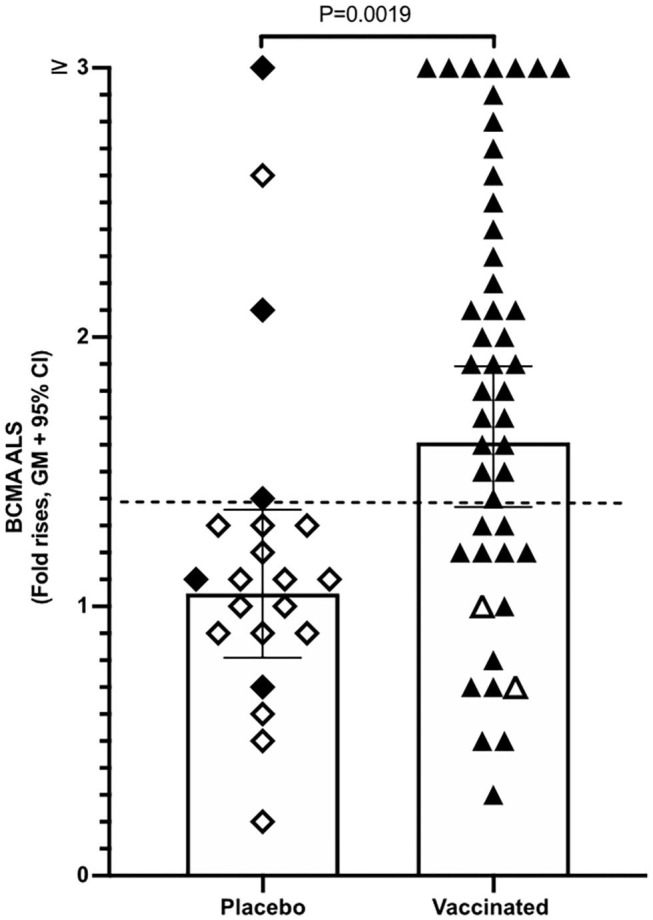
ALS BCMA responses is higher in orally vaccinated subjects than in placebo recipients. Magnitudes of ALS BCMA responses from volunteers were primed with 2 oral doses 2 weeks apart (day 0 and day 14), of either vaccine buffer (placebo group, n = 21), or the oral ETVAX vaccine, administered with or without 10 μg dmLT (n = 46). Each symbol represents one individual. Filled diamonds or triangles represent individuals who responded to at least one ETVAX vaccine antigen in ALS IgA. Open diamonds and triangles represent subjects that did not respond to any of the vaccine antigens in ALS. ALS BCMA responses higher than the arbitrarily chosen level of 1.4 is indicated by a dashed line. Bars represent geometric means with 95% CI.